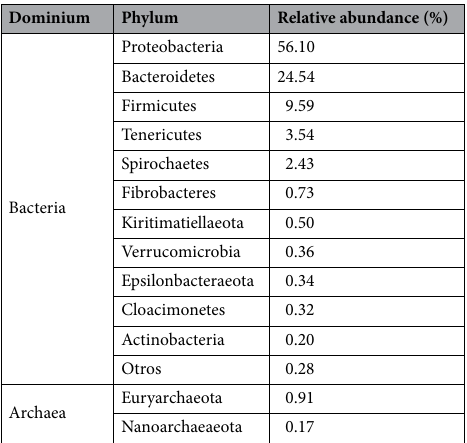
Table 4. Relative abundance of different edges identified in biofilm of polyethylene rings.